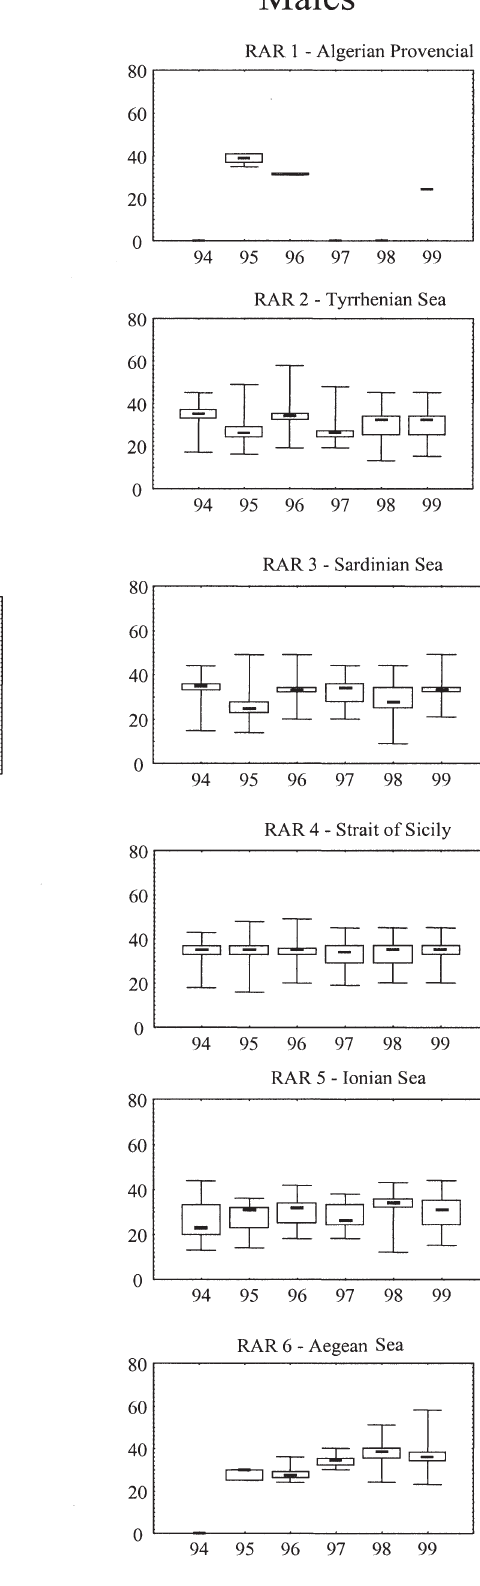
F IG . 5. – Box plot representation of minimum, maximum, and median ( ± SD) Carapace Length (mm) for male and female Aristaeomorpha foliacea in each